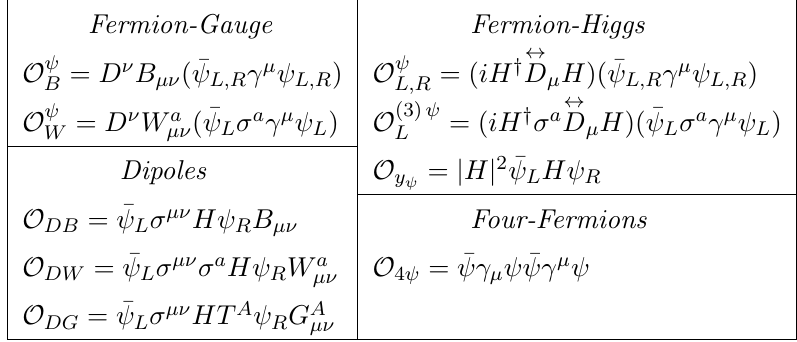
Table 4 . Dimension-6 operators involving fermions relevant for our